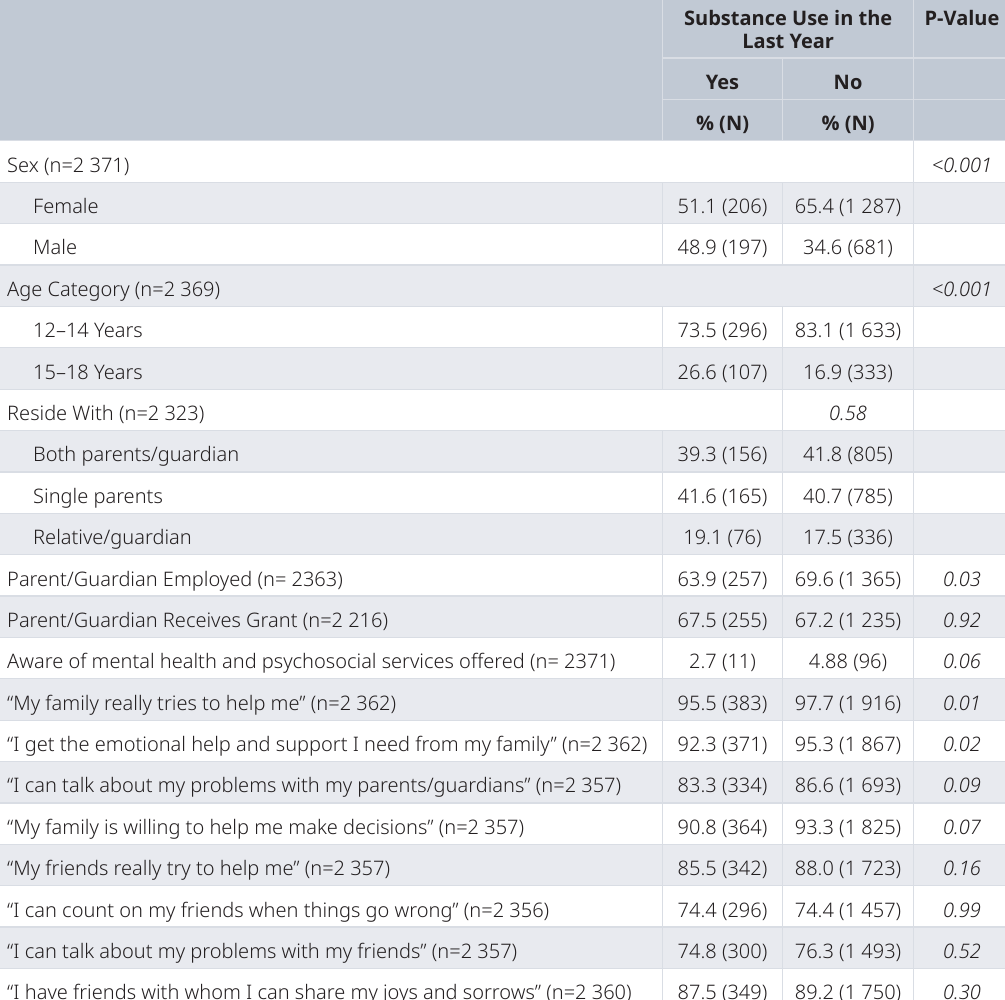
Table 4. Socio-demographic and social support variables by substance use in the last